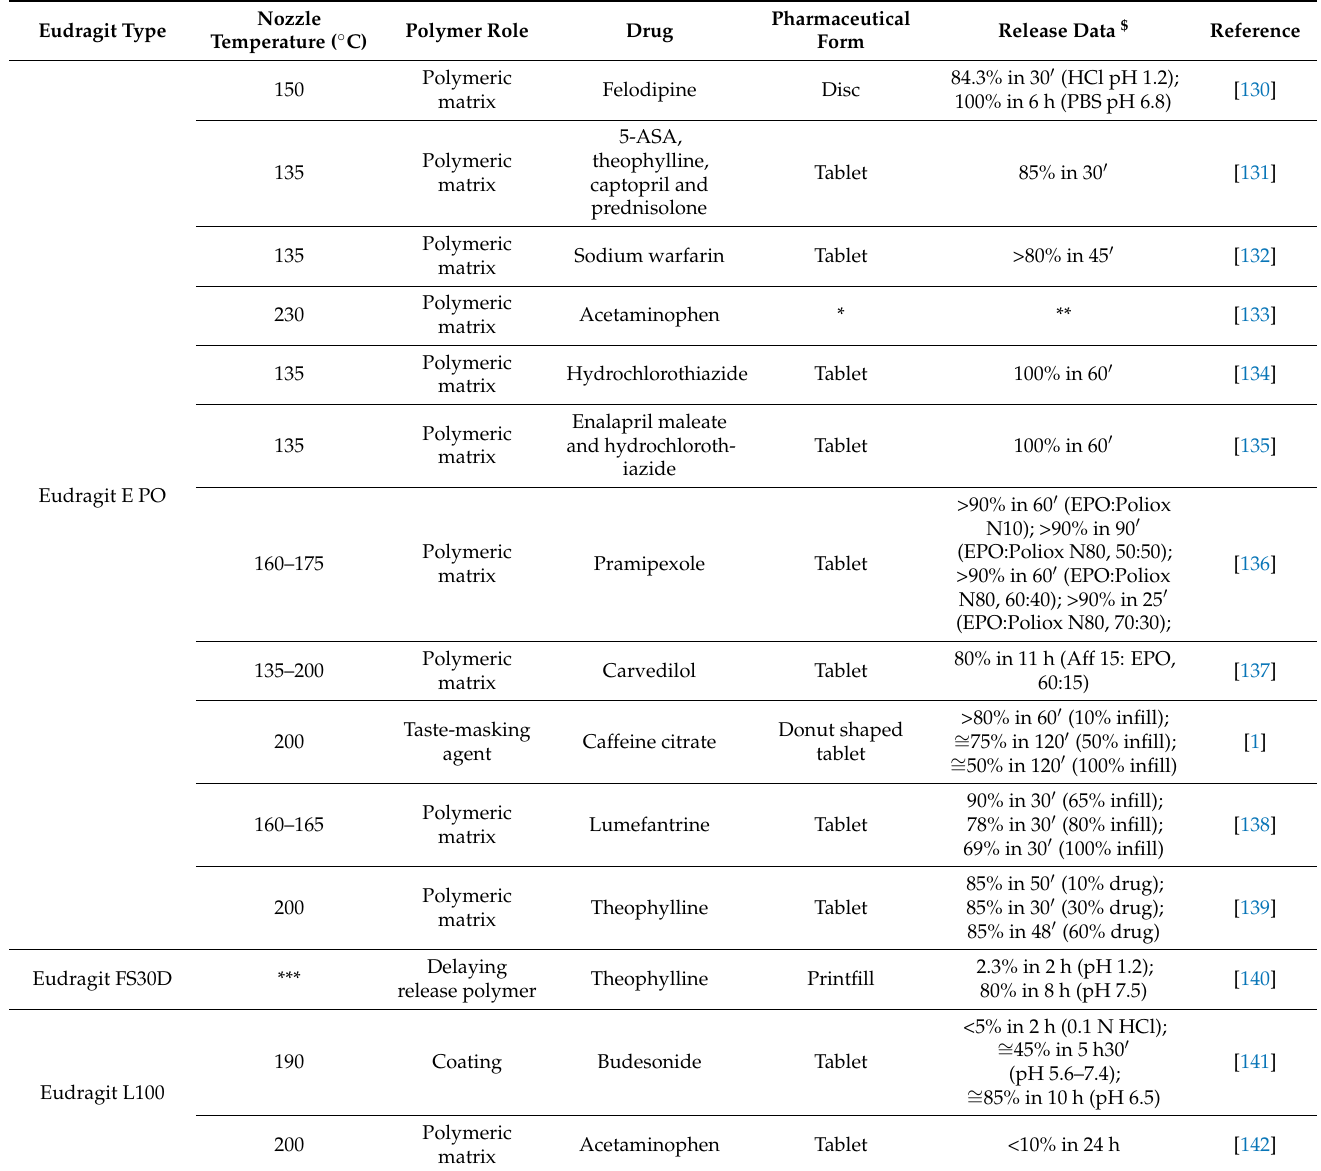
Table 5. 3D printed products by FDM technique using Eudragit